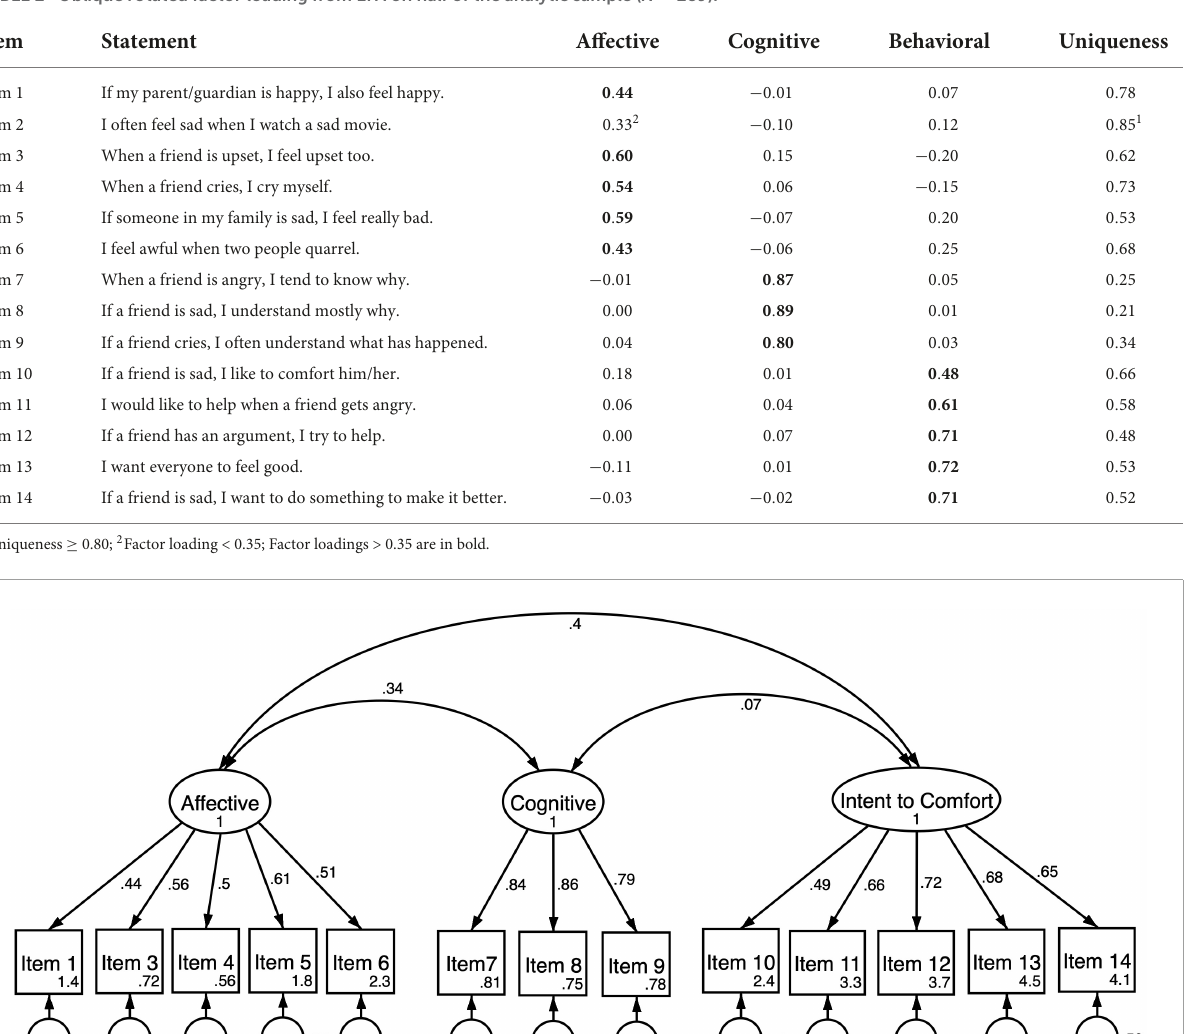
TABLE 2 Oblique rotated factor loading from EFA on half of the analytic sample ( N = 289).